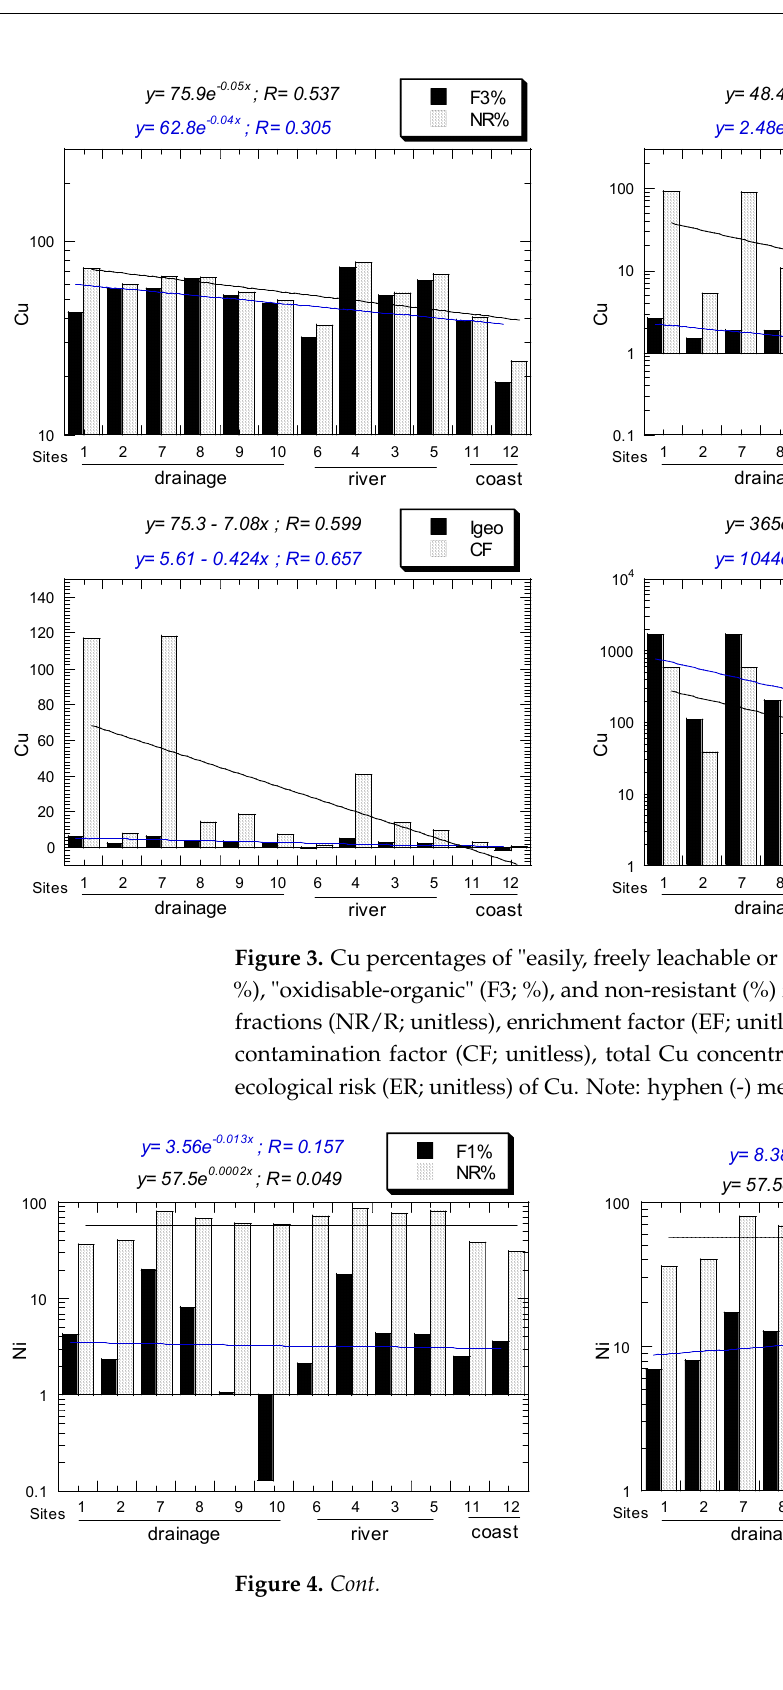
F3% NR% y= 62.8e -0.04x ; R= 0.305y= 75.9e -0.05x ; R= 0.537